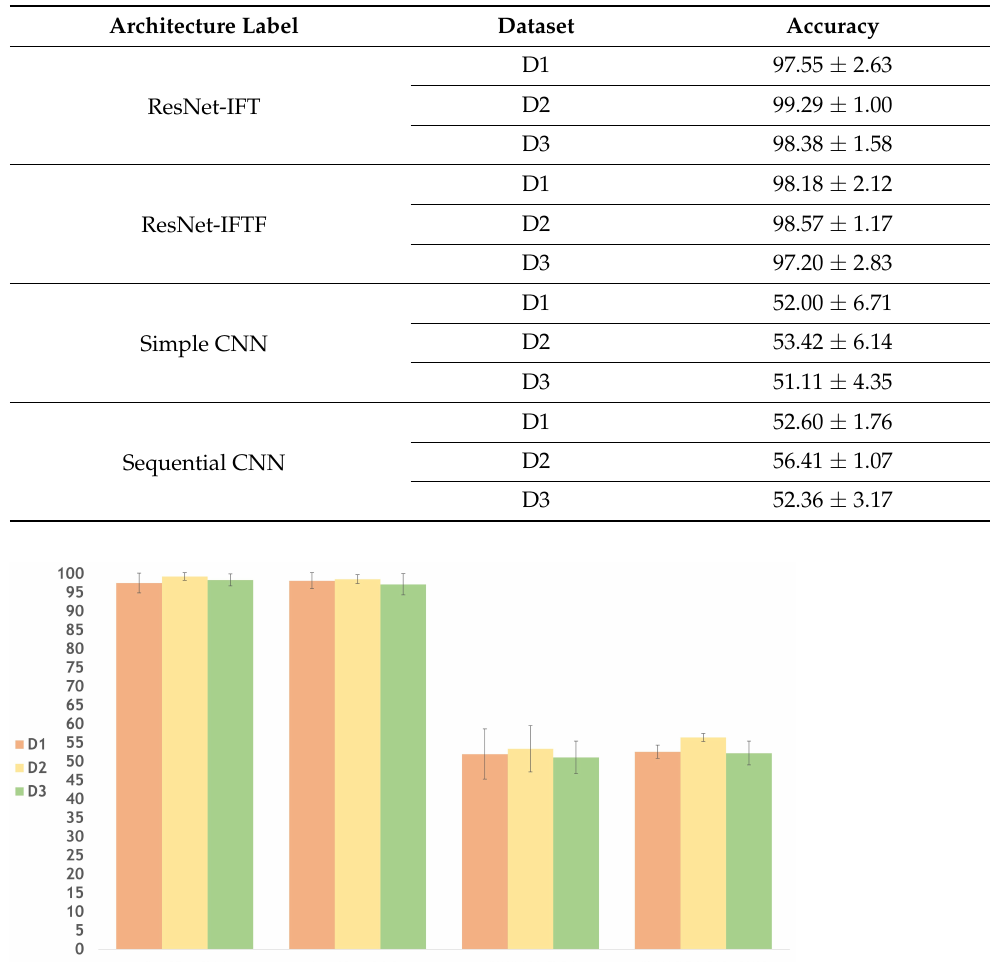
Table 3. Performance evaluation of CNN architectures.